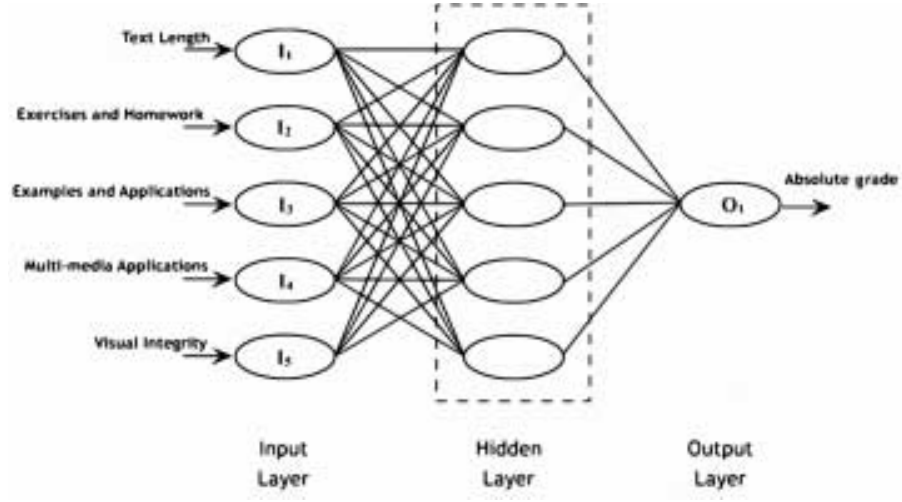
Figure 1. Typology of feed-forward neural network